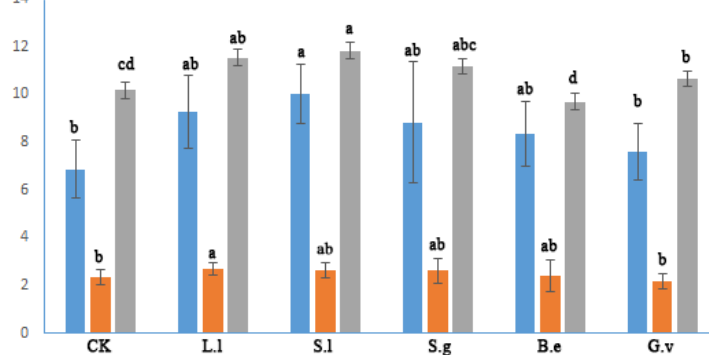
Figure 2. Effects of ECM inoculation on P. tabulaeformis seedling growth: L. laccata (L.l), S. luteus (S.l), S. grevillei (S.g), B. edulis (B.e), G. viscidus (G.v), and treated with steriled substance (CK). Colours denote plant characteristics: blue (plant height, cm); orange (plant base diameter, mm); grey (number of lateral roots). The different letters in the same colours denote significant differences ( p < 0.05) between the treatments, according to Duncan’s multiple range test. The error bars refer to standard deviation. Table 2. Effects of ECM treatments on the biomass of P. tabulaeformis seedlings grown in soil inoculated with: L. laccata , S. luteus , S. grevillei , B. edulis , G. viscidus , and treated with sterilized substance (CK). The different letters denote significant differences ( p < 0.05) between treatments, according to